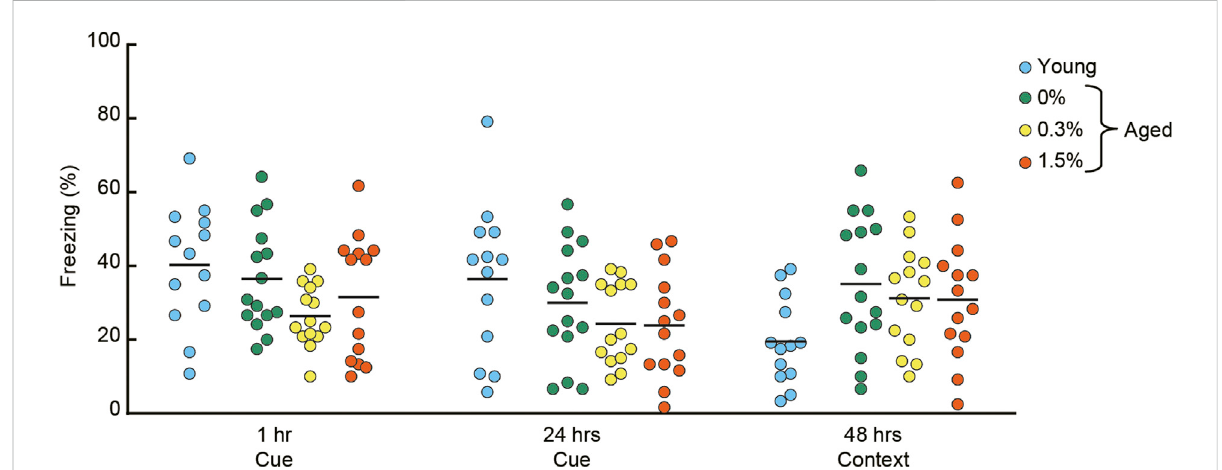
FIGURE 6 Cilostazol has no effect on Pavlovian fear conditioning. After conditioning with a tone CS and shock US, conditioned freezing was sequentially assessed for cue-dependent fear memory (1 h and 24 h after the conditioning), followed by context-dependent fear memory (48 h after conditioning). Scatter dot plot representing percentage of conditioned freezing. One-way ANOVA showed that aged mice receiving the three cilostazol dosages showed asimilar level of freezing throughout thetask. Inthe graph, 0%, 0.3%, and 1.5% represent theconcentration